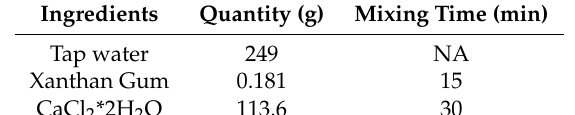
Figure 5. Flow curve of an investigated bentonite gel pill (solid blue line) and the laponite gel pill (dotted red line). Table 6. Mix design and mixing procedure for the viscosified brine.